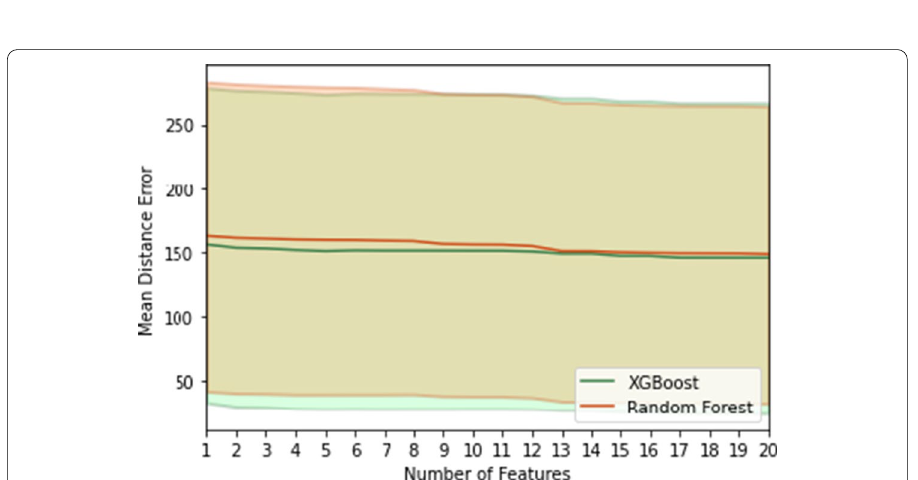
Fig. 19 Mismatching effects over euclidean distance error for random forest model and for gradient boosting